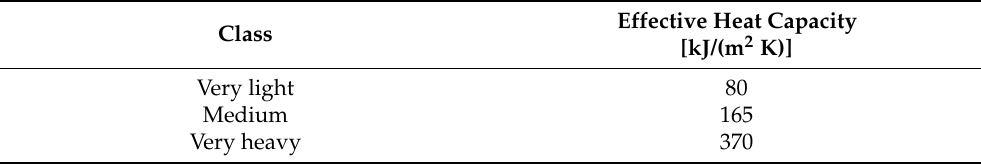
Table A1. Selected heat capacities for